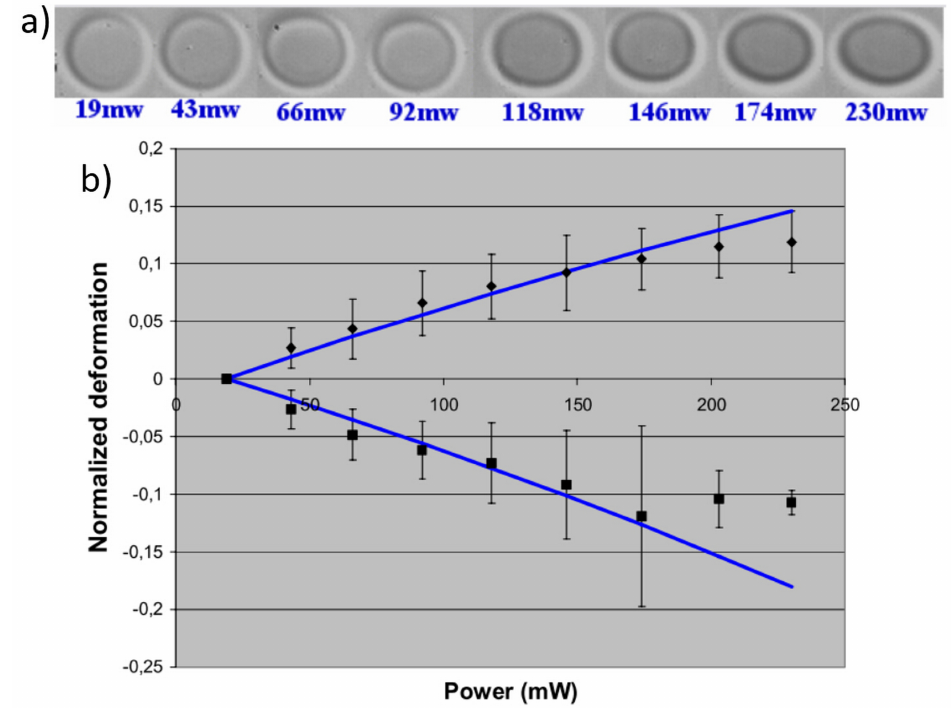
Figure 12. Optical stretching of single red blood cell (RBC). ( a ) Microscope images of RBCs stretched at increasing optical powers; ( b ) Optical deformation of RBCs in terms of elongation along laser axis and contraction in the perpendicular direction at different stretching power. The laser power is the total power for both laser beams. Experimental data is fitted with theoretical prediction from the linear elastic membrane theory. Figure reproduced from Reference [45] with permission from Optical Society of